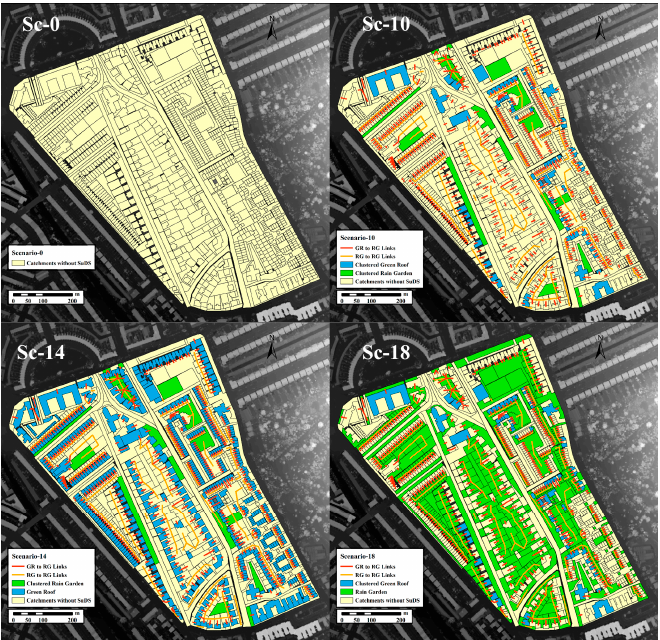
Figure 6. Sketch maps of different decentralized strategies. In scenario 10, 622 GR units are clustered in 69 mini-catchments and 527 RG units are clustered in 18 mini-catchments; scenario 14, 622 GR units are decentralized in 622 mini-catchments and 527 RG units are clustered in 18 mini-catchments; scenario 18, 622 GR units are clustered in 69 mini-catchments and 527 RG units are decentralized in 527 mini-catchments.